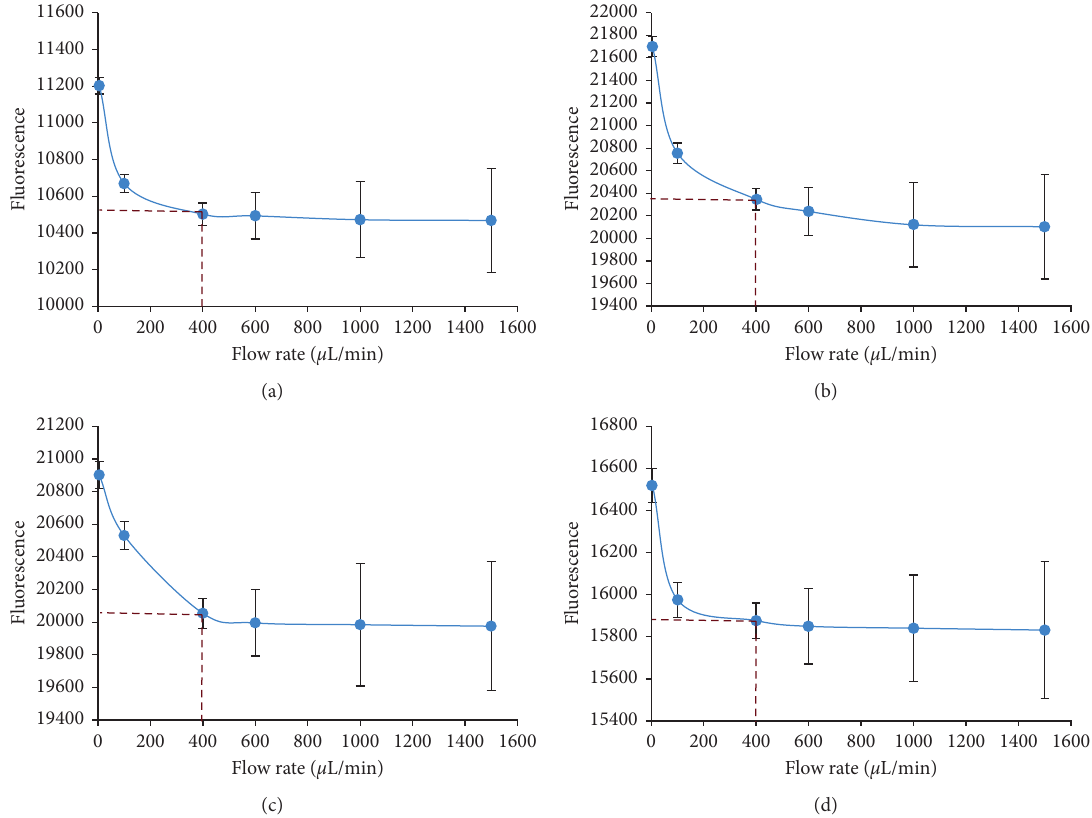
Figure 2: Effect of flow rate: (a) ciprofloxacin, (b) ofloxacin, (c) levofloxacin, and (d) moxifloxacin. Condition: concentration 5 μ g · mL − 1 ; integration time: